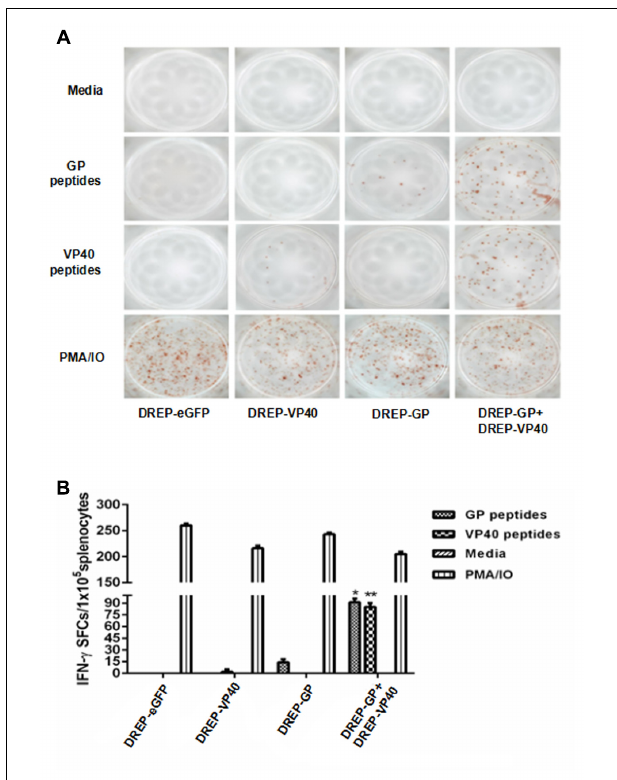
FIGURE 6 | ELISPOT analysis of IFN- γ secreting CD8 + T cells from immunized mice upon stimulation with GP- and VP40-specific epitopes. Splenocytes were isolated from plasmid-immunized mice and were stimulated in vitro with GP- or VP40-specific epitopes. A positive control (PMA/IO) and a negative control (Media) were included. IFN- γ -specific spot forming was observed (A) , and the numbers of IFN- γ SFCs/1 × 10 5 splenocytes were counted (B) . The results for three independent experiments are shown as the mean ± SD. ∗ p < 0.05; ∗∗ p <